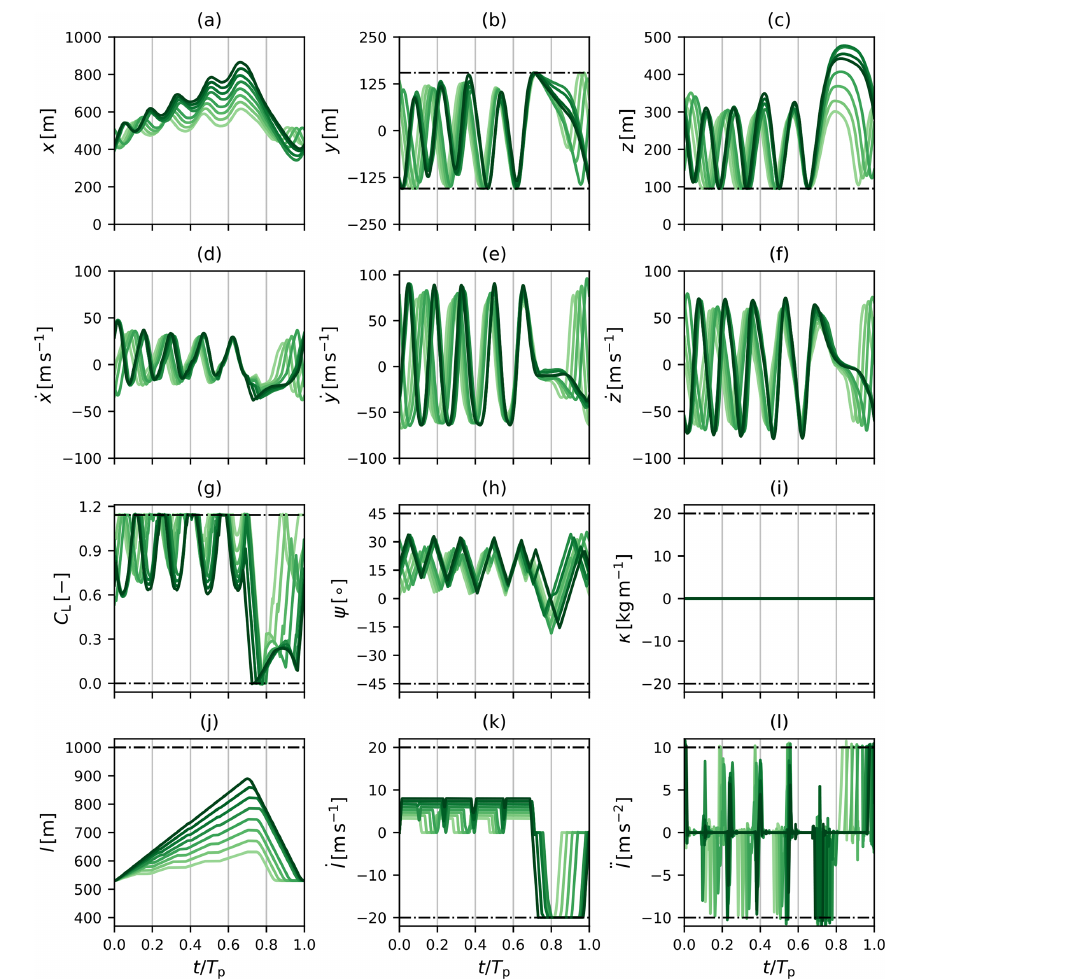
Figure B1. Time series of the states normalised over one period T p for the large-scale lift-mode AWE system (2) optimised for the wind speed range U D = [ 5 . 0 , 12 . 0 t ] . The position q and velocity ˙ q are respectively shown in the (a–b) and (d–f) . The wing lift coefficient C L , roll angle (cid:57) , and on-board turbine thrust coefficient κ are shown in the (g–i) . The tether variables l , ˙ l , and ¨ l , representing the length, speed, and acceleration of the tether, are shown in (j–l) . The colour scheme is identical to Fig. 3, and the black dashed lines represent the eventual constraints applied to the variables in POCP (Eq.